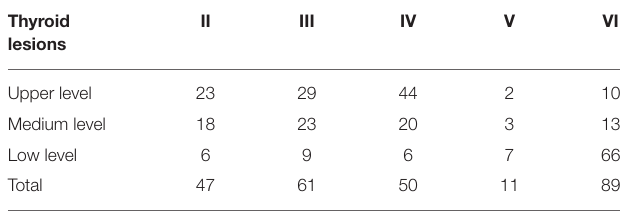
TABLE 1 | Distribution of thyroid lesion sites and regional lymph nodes (cases).